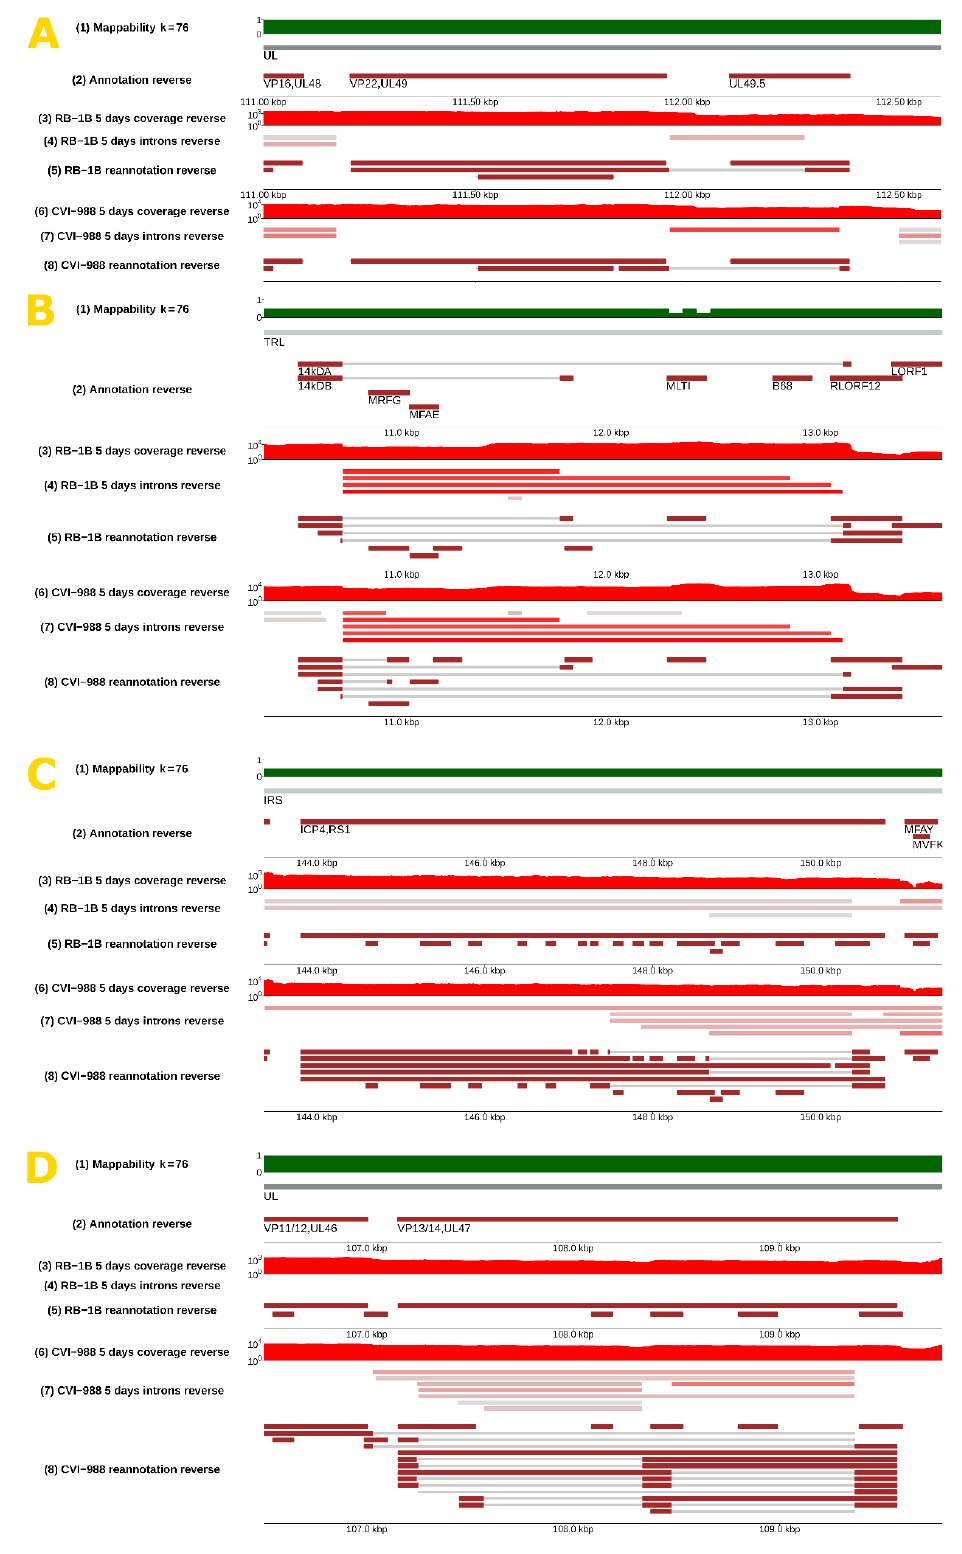
Figure 5. Tentative condition-dependent reannotation of splicing events on the reverse strand of MDV. In silico reconstructed coding spliced transcripts compatible with the introns observed from Illumina short sequencing read—the coding spliceforms shown in each panel were produced by automatic prediction methods (see the Materials and Methods section ), but the presence of full-length